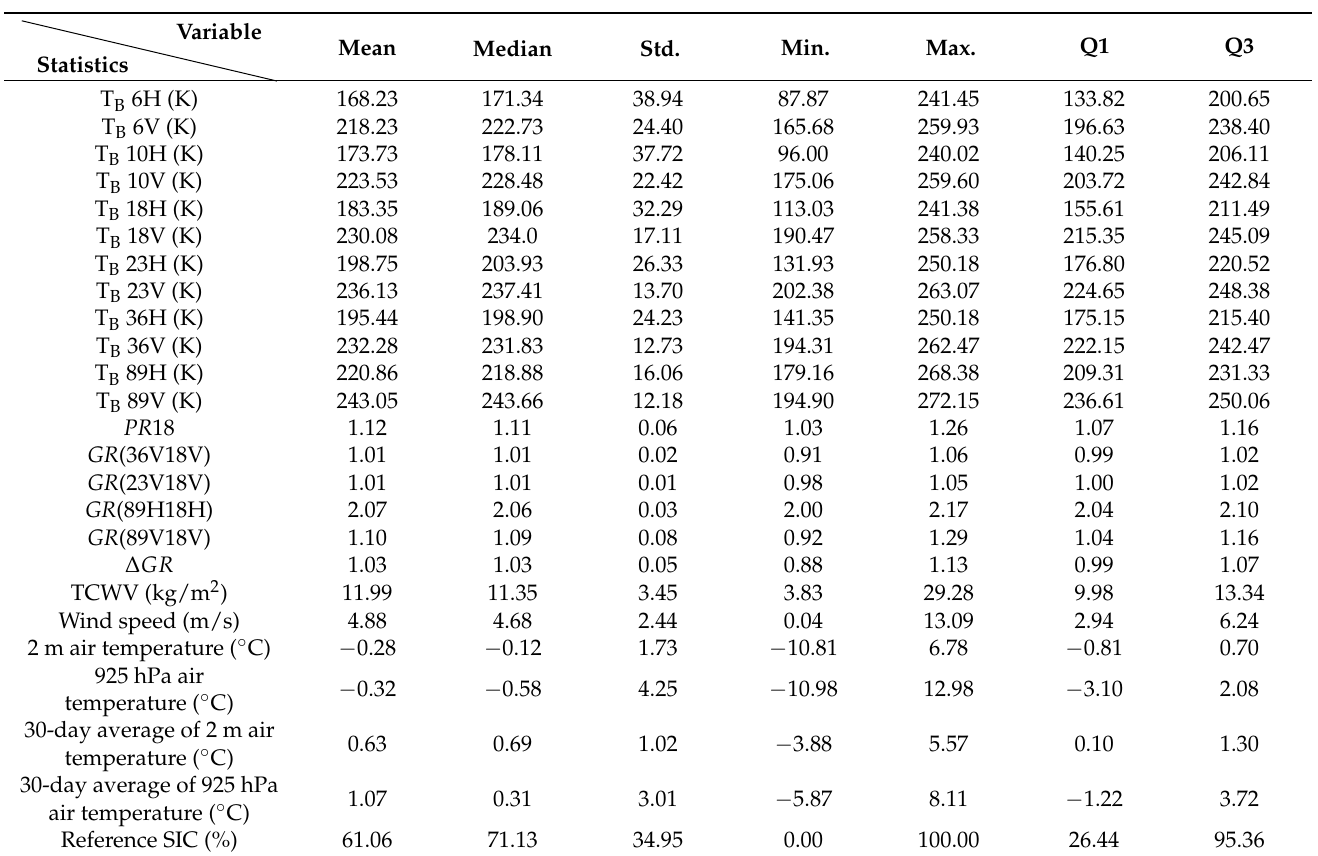
Table 2. Descriptive statistics of the input variables used in the training and validation samples for the RF model ( T B : brightness temperature, H : horizontally polarized channel, V : vertically polarized channel, Q1: 25th percentile, Q3: 75th